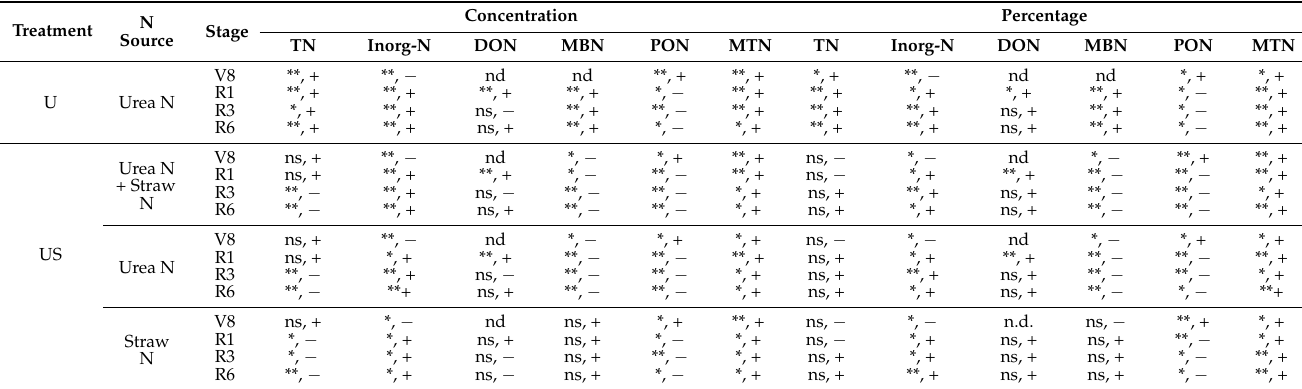
Table 2. Statistical analysis of the concentration and percentage of applied N in different soil N pools between bulk soil and rhizospheric soil under urea (U) and urea plus straw (U + S) treatments at maize growth stages of 8th leaf (V8), silking (R1), milk (R3), and physiological maturity (R6) (data shown in Figures 2–8).